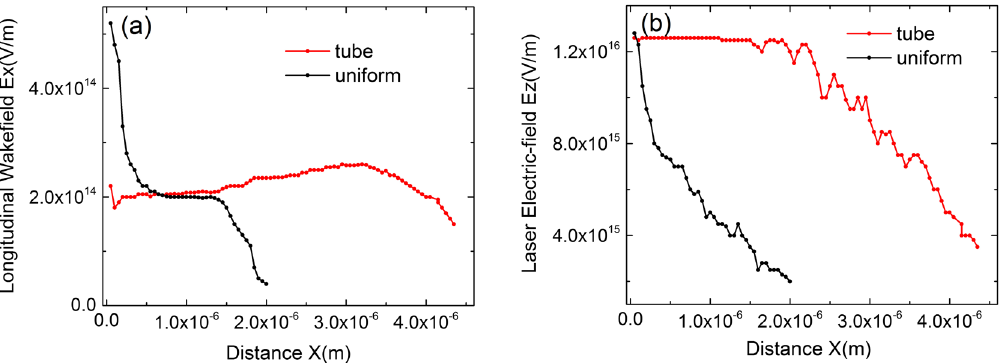
FIG. 3. Evolution of the maximum longitudinal wakefield E x ð V = m Þ and the laser field E z ð V = m Þ as the function of propagation distance x ð m Þ for both nanotube (red dotted line) and uniform plasma (black dotted line) cases with the same conditions as Fig.